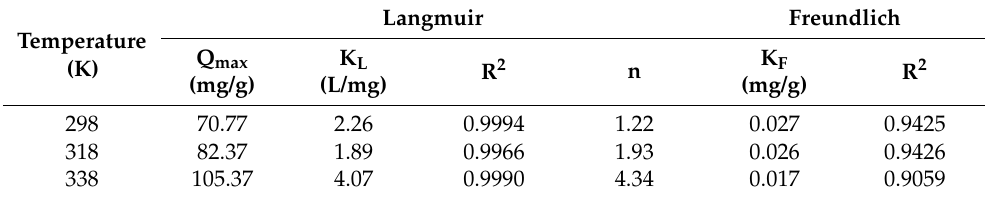
Table 2. Freundlich and Langmuir constants and correlation coefficients for adsorption of phosphate onto Fe 3 O 4 @La(OH) 3